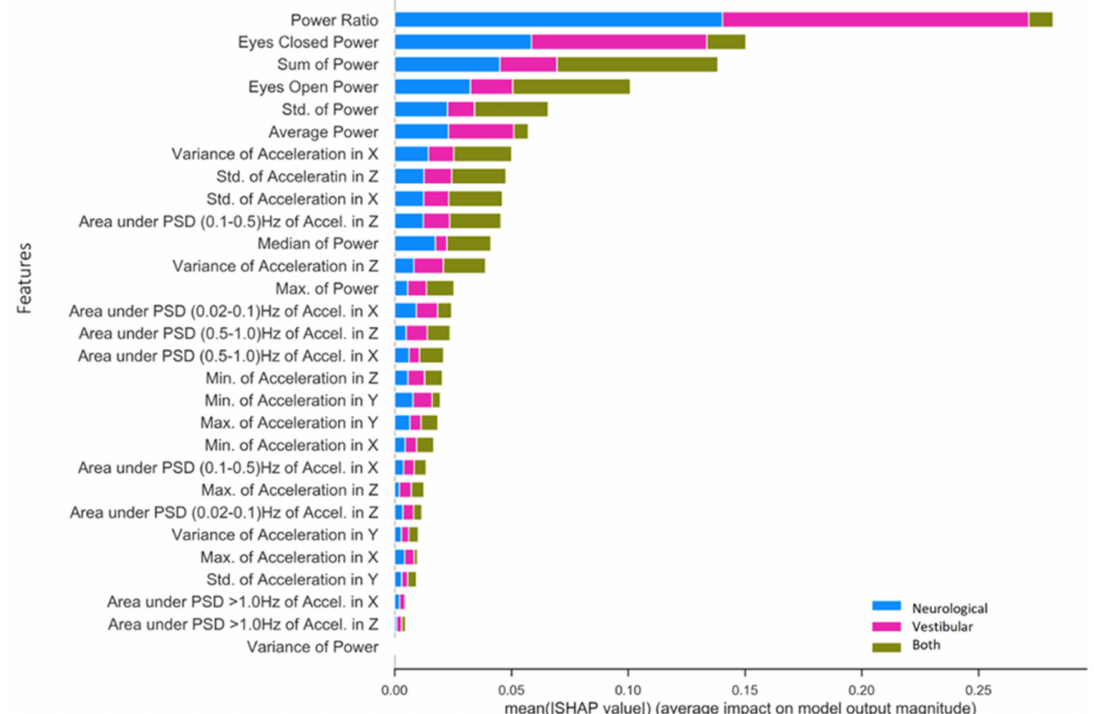
Figure 5. Mean SHAP value contribution ( x -axis) of each feature ( y -axis) for every impairment condition (blue = neurological, pink = vestibular, green = both), ranked from top to bottom in terms of importance. Taking each class together, the total mean SHAP value reflects each feature’s global impact on model